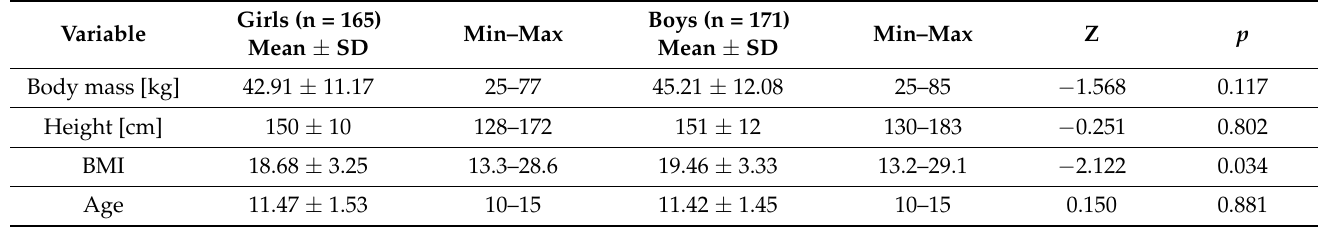
Table 1. Basic characteristics of the study